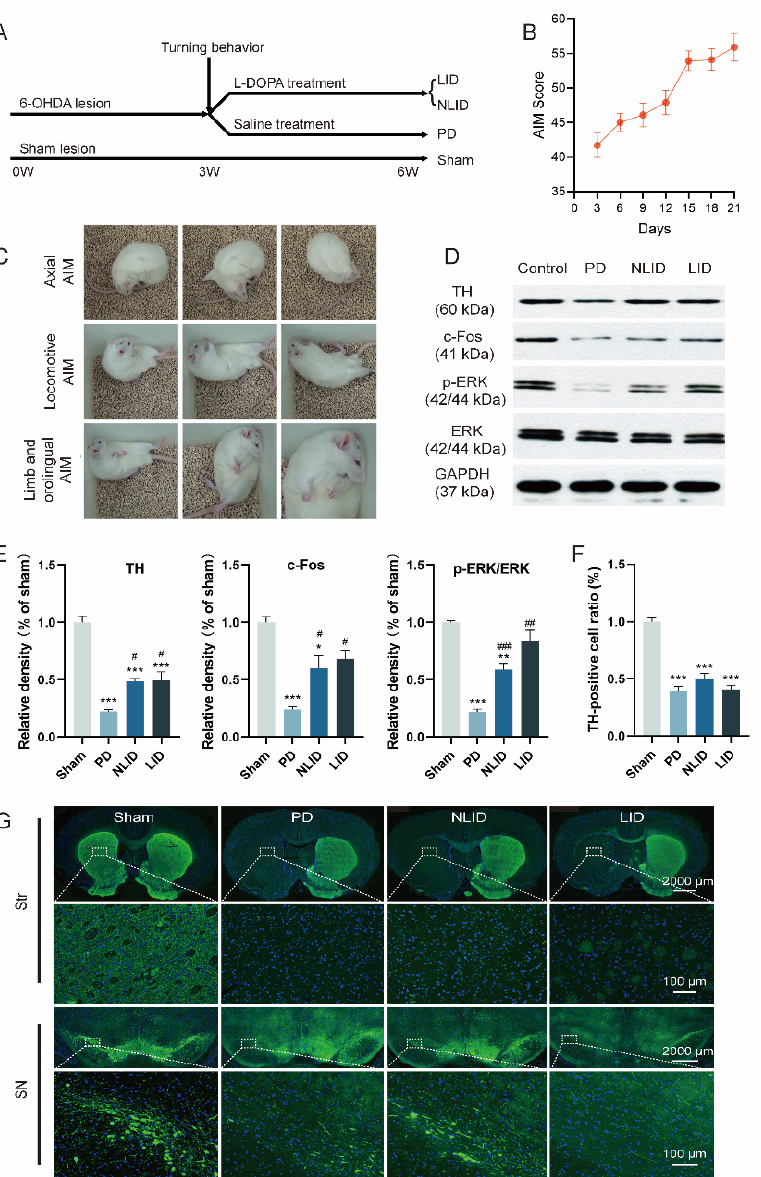
Figure 1. Validation of the levodopa-induced dyskinesia (LID) rat model. ( A ) Experimental timeline. A unilateral Parkinson’s disease (PD) rat model was established by 6-OHDA stereotactic intracerebral injection of the right medial forebrain bundle. Contralateral rotation was induced by apomorphine intraperitoneal injection 3 weeks later. The validated PD rats were administered with L-DOPA and benserazide for 3 weeks to induce a rat model of dyskinesia. Involuntary movements (AIMs) were rated every 3 days during the treatment. ( B ) AIMs of LID rats at various times. At 30 min intervals, AIMs were rated for 60 s for each rat for a total of 180 min. For each AIM category, the scores were summed for each time point. Data are shown as mean ± SEM ( n = 15). ( C ) The typical AIM of